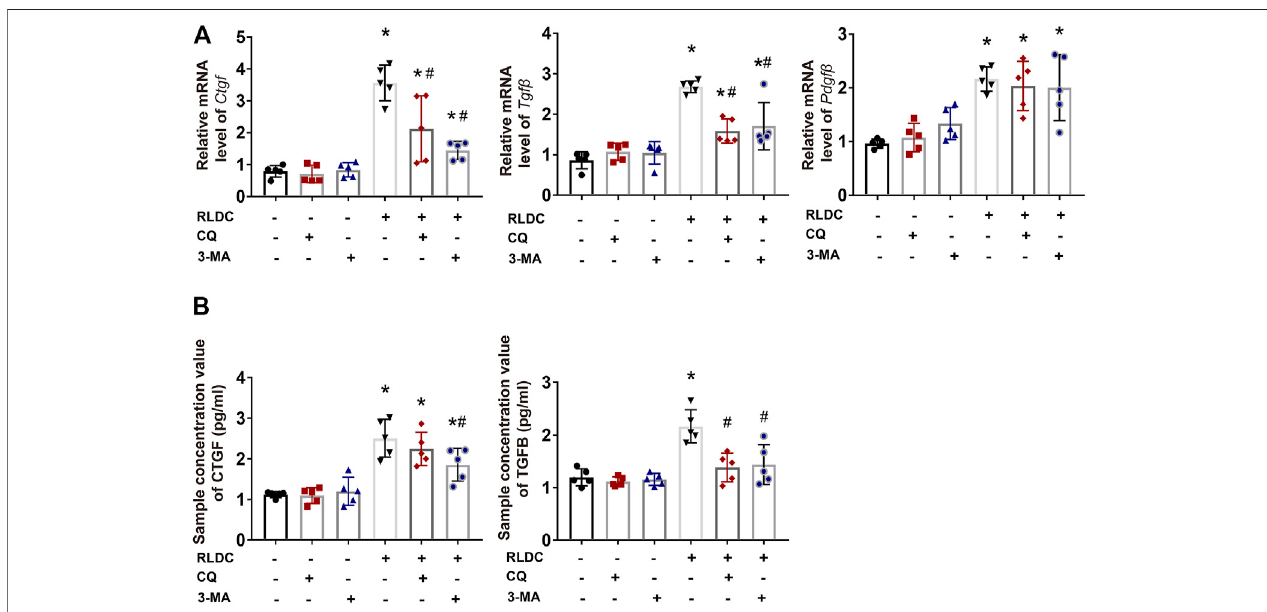
FIGURE6| Autophagyinhibitorssuppresstheexpressionandsecretionofpro- fi broticgrowthfactorsinRLDC-treatedBUMPTcells.BUMPTcellswereincubated with 2 μ M cisplatin for 7 h each day for 4 days (RLDC) or without cisplatin exposure (Con). After the last 7 h of cisplatin treatment, cells were incubated with 20 μ M chloroquine (CQ) or 10 mM 3-methyladenine (3-MA) for 17 h in cisplatin-free medium. (A) The mRNA levels of Ctgf, Tgfb β and Pdgf β in cells quanti fi ed by qRT-PCR showingtheinhibitoryeffectofCQand3-MA( n =5).Dataarenormalizedto Gapdh andexpressedasfoldchangecomparedtocontrols. (B) CTGFandTGFBincell culture medium detected by Elisa. ( n = 5). Data are expressed as mean ± SEM. * p < 0.05 vs the control group (Con). # p < 0.05 vs. (RLDC + vehicle)